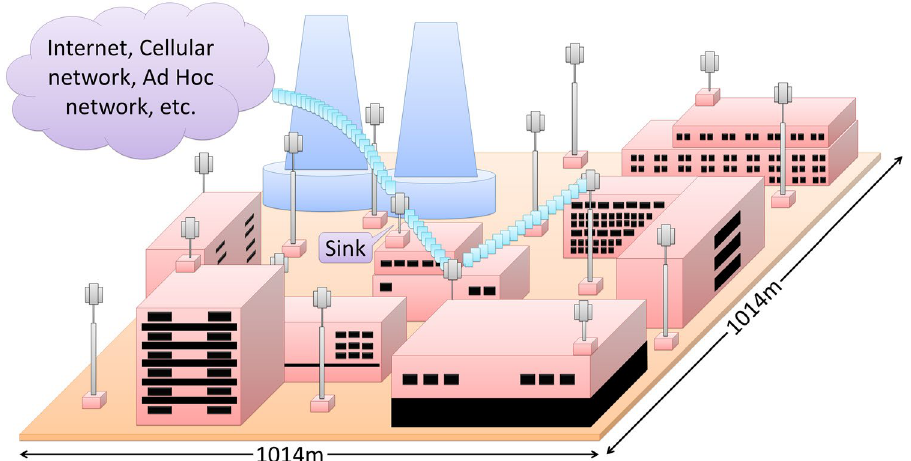
Figure 1. An imagination of WSNs employed nuclear power plant.